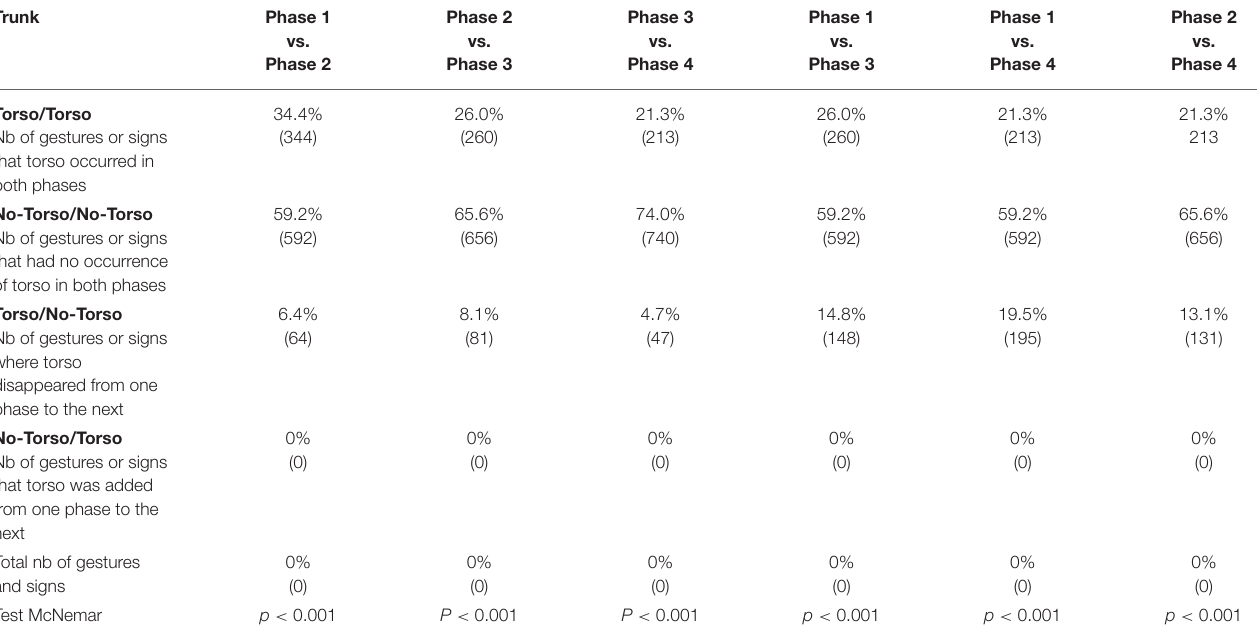
TABLE 2 | McNemar Test: Comparison of pair of phases based on the number of gestures or signs in which torso occurred and not occurred considering the analyzed 1,000 gestures and signs.